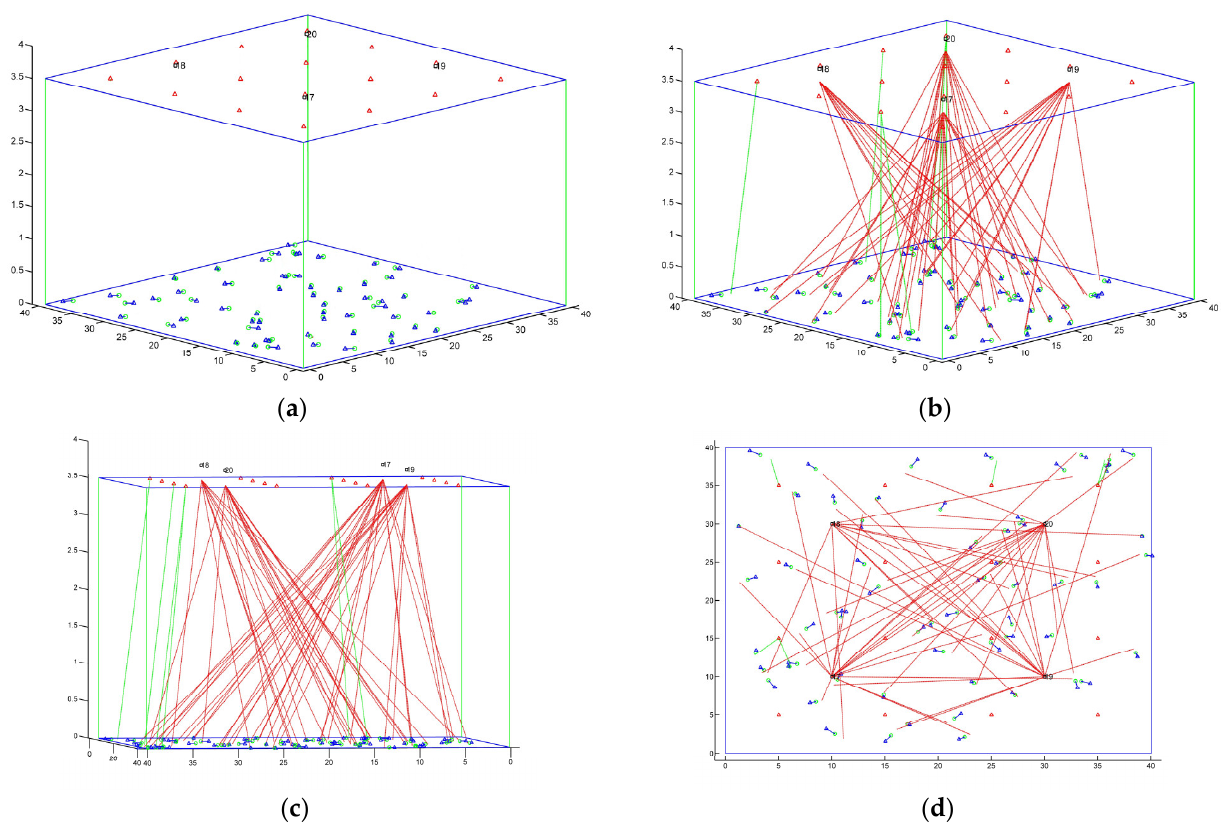
Figure 8. Snapshots from the simulation running (60 users). ( a ) at the start of the simulation, ( b ) during execution which shows user assignment to APs, ( c ) side view, and ( d ) upper view.